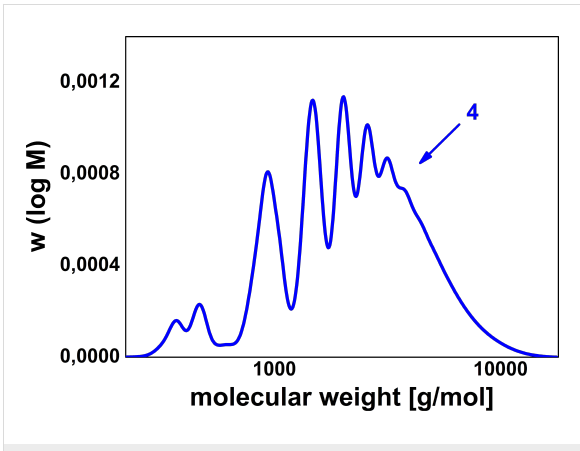
Figure 3: GPC curve of epoxide-amine product 4 detected by UV absorption.